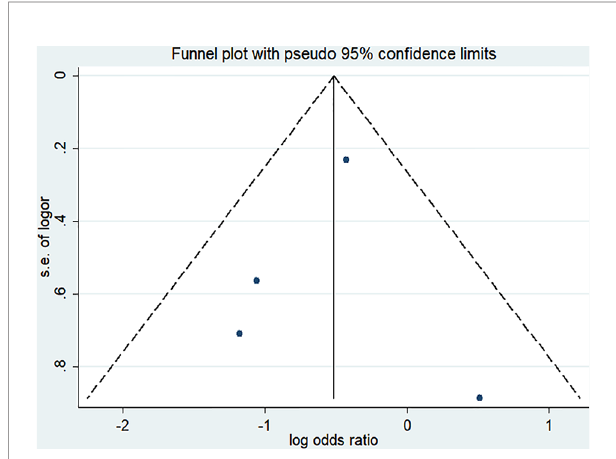
FIGURE 3 | Funnel plot of studies discussing ICU mortality. The funnel plot did not show distinct